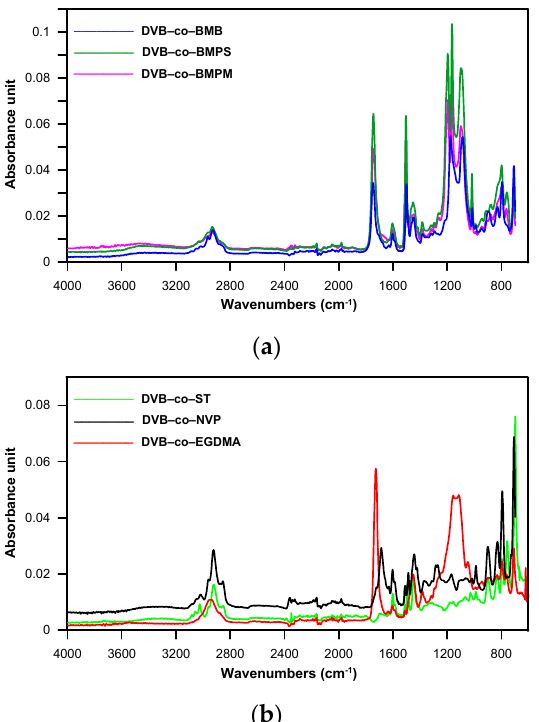
Figure 2. ATR-FTIR spectra of copolymeric microspheres. ( a ); DVB- co -BMB, DVB- co -BMPS and DVB- co -BMPM ( b ) DVB- co -ST, DVB- co -NVP and DVB- co -EGDMA